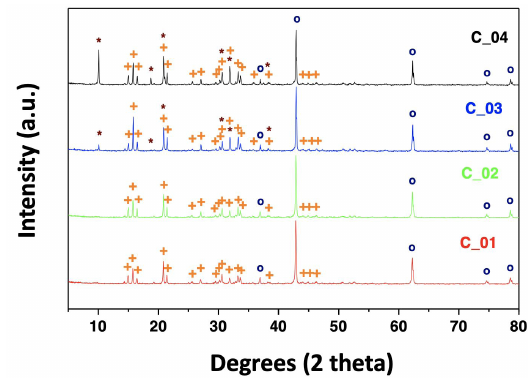
Figure 4. X-ray diffractograms of CBPC compositions prepared from MgO powders calcined at 900 °C / 2 h, with different MgO/NH H PO ratios, by mass. (Phases: + struvite; * dittmarite; 4 2 4 o